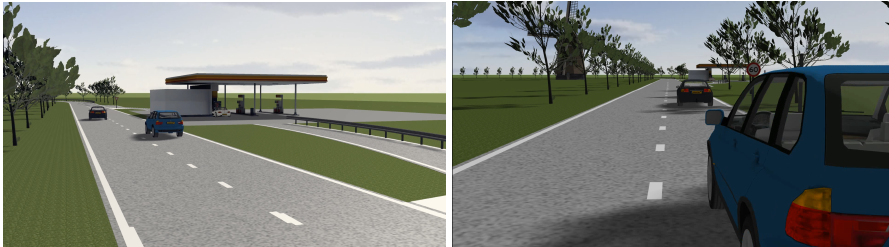
Figure 3. Observer ( rear ) and maneuvering vehicle ( front ) in the simulation.